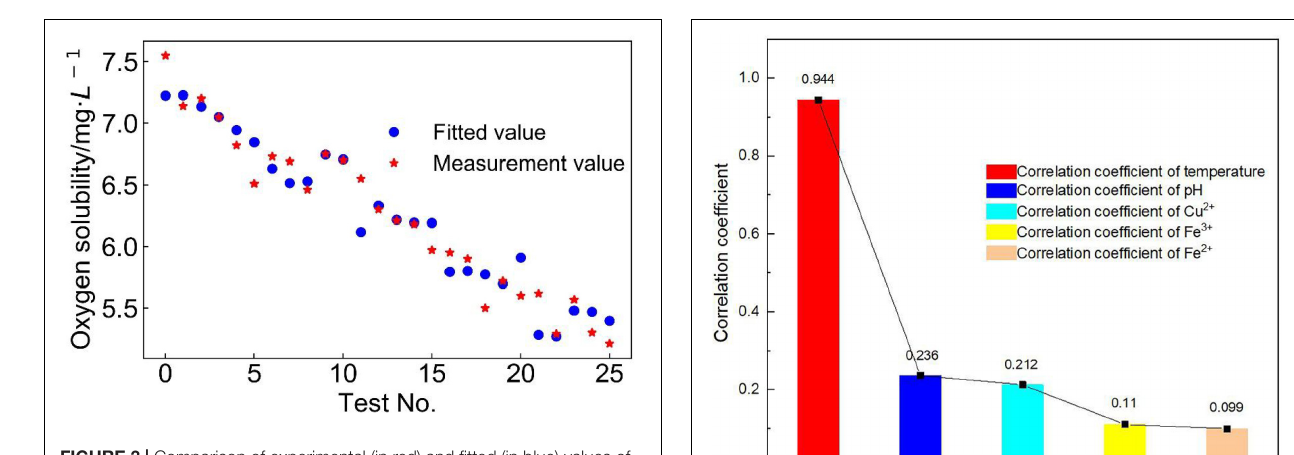
FIGURE 3 | Comparison of experimental (in red) and fitted (in blue) values of dissolved oxygen concentration in copper bioleaching solutions.